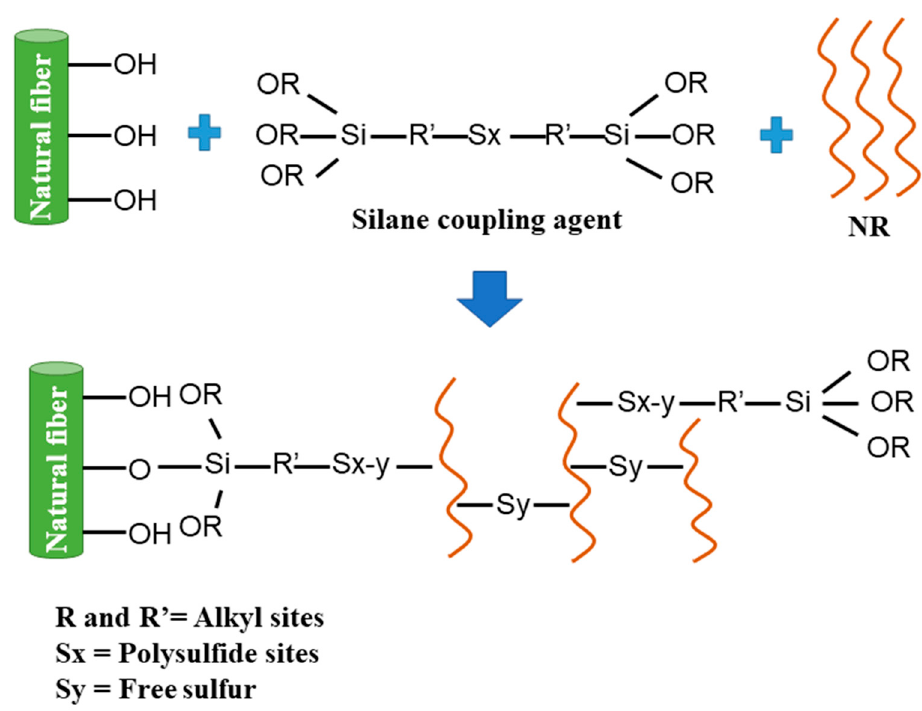
Figure 5. The mechanism of silane coupling agent treatment in rattan/NR composites.